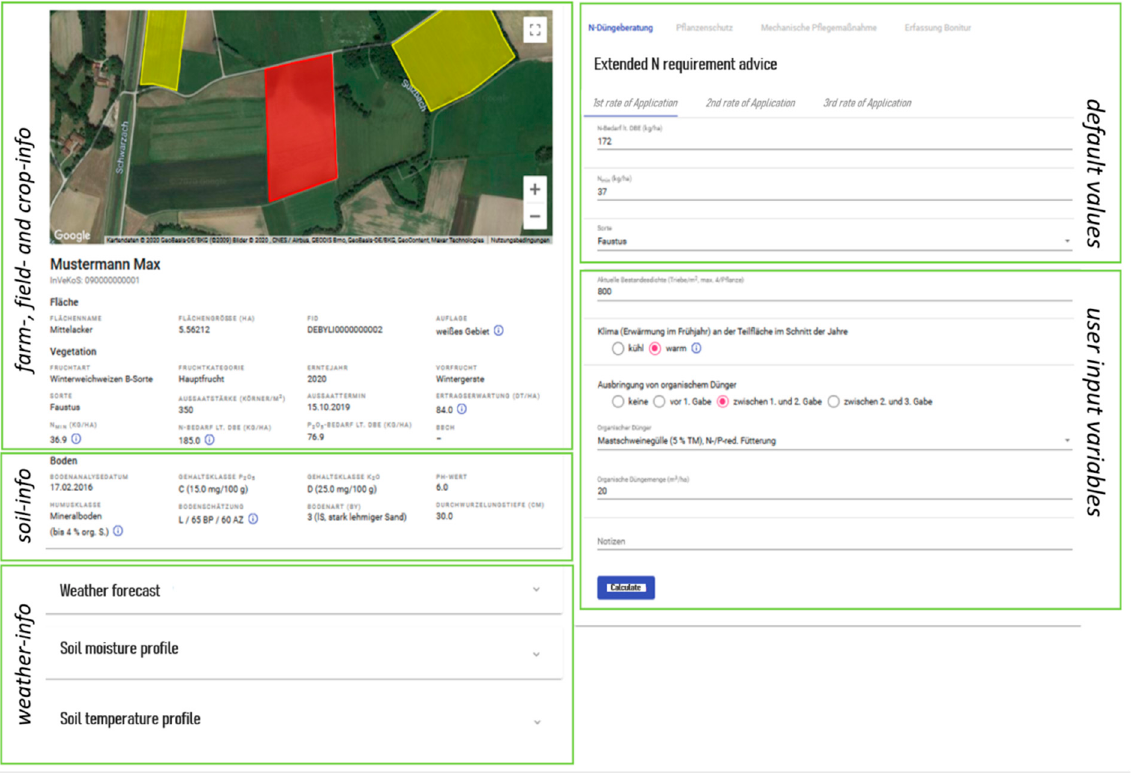
Figure 6. Structured user interface with information on the farm, area, crop, and soil ( left ), a dropdown menu of weather parameters ( bottom left ), and input variables for application advice entered by the user ( right ).